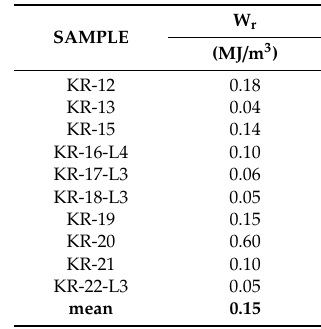
Table 4. Results for work done in disintegrating particular samples.